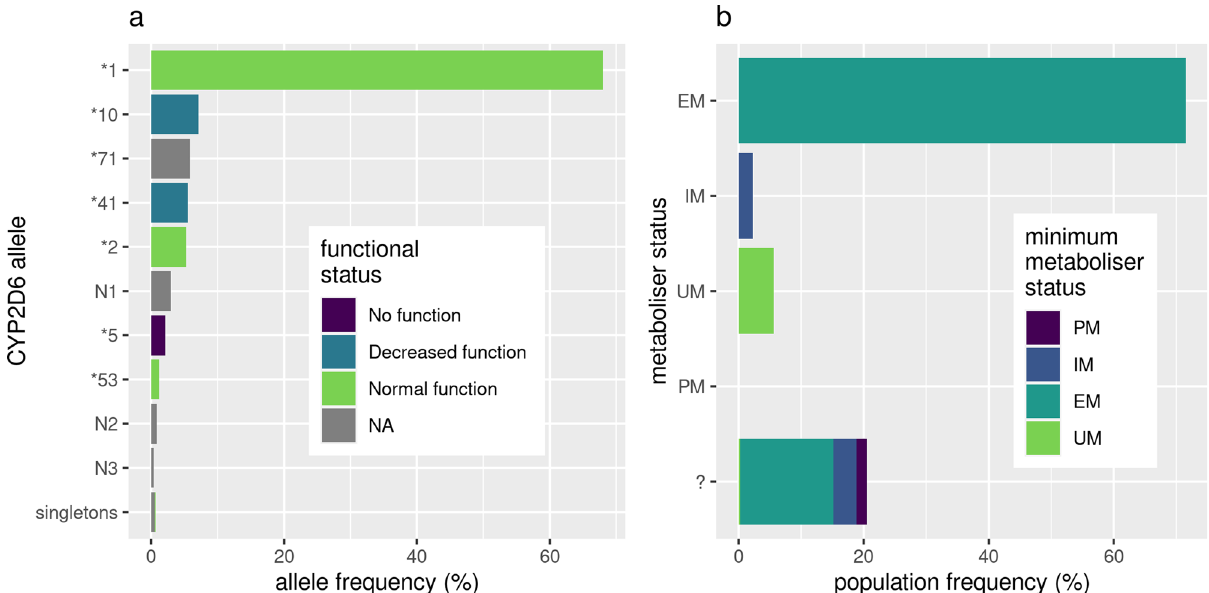
Fig. 3 Frequency and activity of CYP2D6 alleles in the Solomon Islands cohort. a Frequency of CYP2D6 alleles identi fi ed in the Solomon Islands cohort ( n = 355), colored by CYP2D6 functional status from the “ CYP2D6 Allele Functionality Table ” (PharmGKB). Alleles pre fi xed with “ N ” represent novel alleles identi fi ed in this study that contain variants that are likely to impact protein function (VEP MODERATE and HIGH impact), full allele de fi nitions are available in Supplementary Data 5. b Assigned metabolizer status of individuals in the Solomon Islands cohort ( n = 355). In the case an individual contains one or more alleles with unknown function ( “ ? ” ), the minimum metabolizer status is calculated based on the alleles present with known